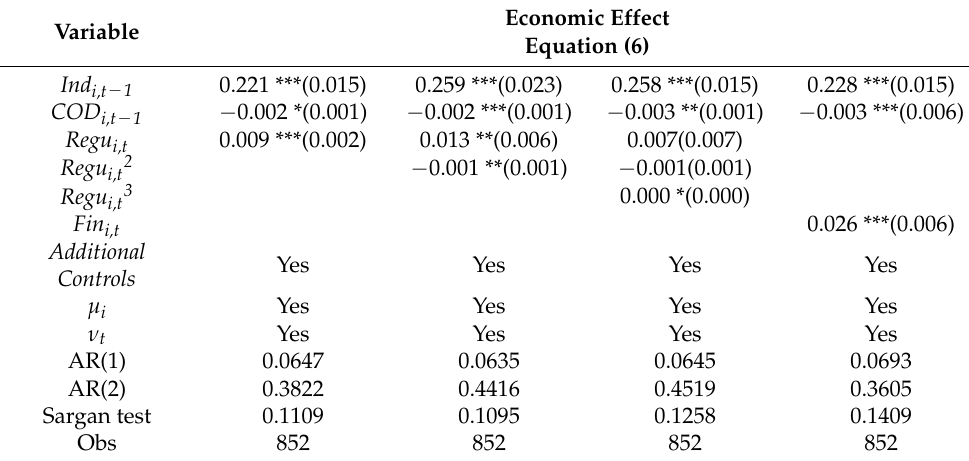
Table 5. The economic effect of local government